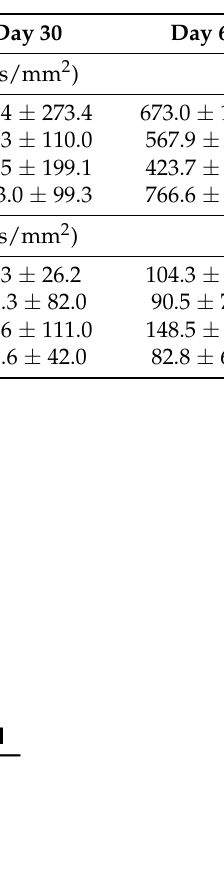
Figure 5. Exemplary histological images of the distribution of anti-inflammatory CD163-positive macrophages ( A – D ) and pro-inflammatory CD11c-positive macrophages ( E – H ) (red staining) within the implant beds of the three membranes within the subcutaneous connective tissue (CT) at day 10 post implantationem. ( A ) BM = native bovine membrane, ( B ) JM = Jason ® membrane, ( C ) BG = Bio-Gide ® membrane, ( D ) Sham operation group without biomaterial insertion (CD163-immunostainings ( A – D ) and CD11c-immunostainings ( E – H ), 200 × magnifications, scalebars = 200 µ m). Table 10. Results of the Macrophage Measurements/Immune Responses.